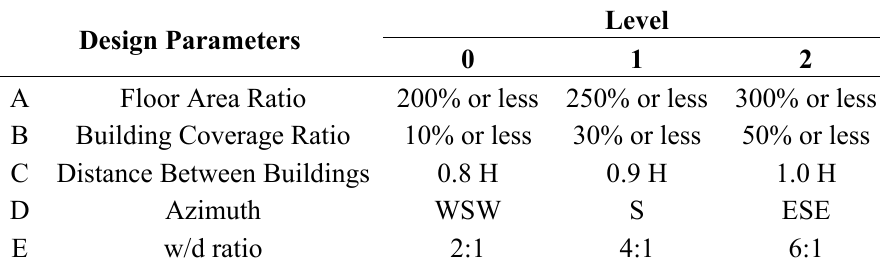
Table 3. Design parameters and